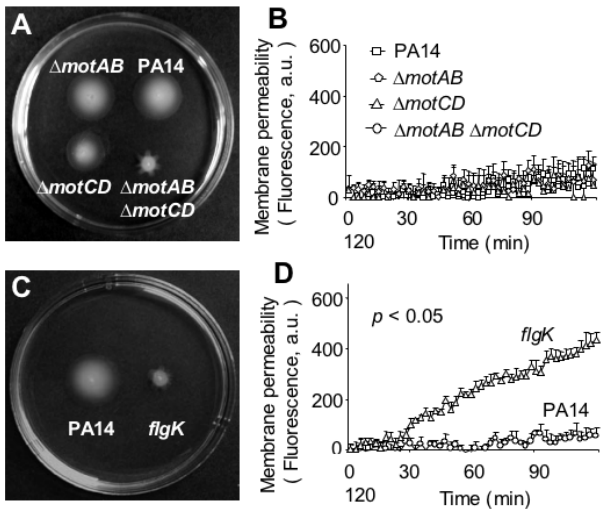
Figure 7. Susceptibility to SP-A-Mediated Membrane Permeabiliza- tion Is Dependent on Intact Flagellum Structure but Independent of Flagellar-Mediated Swimming Motility. (A) Wild-type P. aeruginosa strain PA14 and its isogenic derivative d motAB , d motCD and d motAB , d motCD were tested for swimming motility and susceptibility to SP-A- mediate membrane permeabilization. Mutant strains d motAB and d motCD were motile, but d motAB , d motCD was nonmotile on swimming motility agar plate. (B) All d motAB , d motCD and d motAB , d motCD mutant strains were resistant to SP-A-mediated membrane permeabi- lization, indicating that susceptibility to SP-A is independent of flagellar- mediated motility. (C) The flgK mutant, which could not assemble flagellum, was nonmotile. (D) The flgK mutant was susceptible to SP-A- mediated membrane permeabilization. Data were the mean 6 SE, n =8 for each bacterial strain. The difference in membrane permeabilization between flgK and PA14 was significant from 31 st -min onward. * p , 0.05.